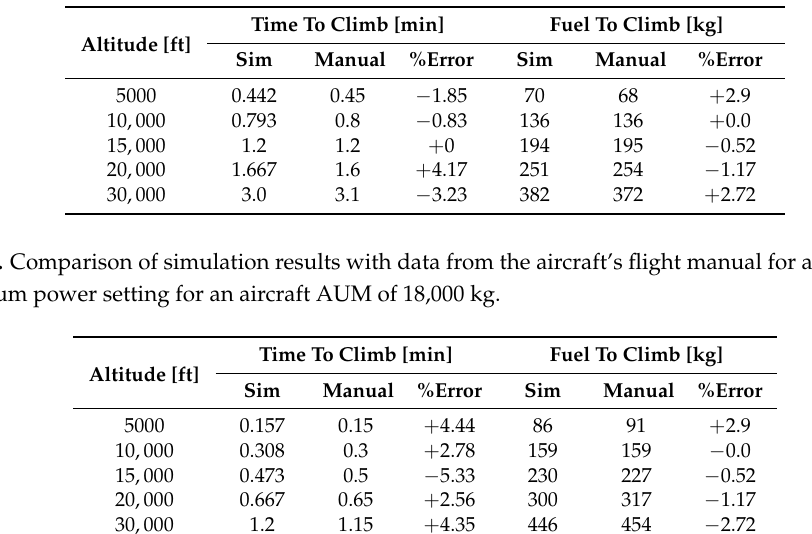
Figure 8. Altitude (h)–Mach number (M) plots of the climb paths used for simulation validation for: military ( a ); and maximum ( b ) power settings. The climb paths are plotted over contours of Specific Excess Power, expressed in m/s. Table 1. Comparison of simulation results with data from the aircraft’s flight manual for a climb with military power setting for an aircraft AUM of 18,000 kg.